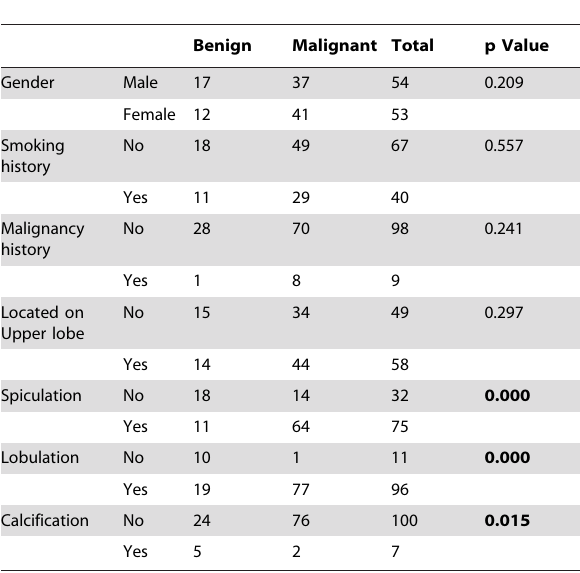
Table 4. Univariate analysis of qualitative